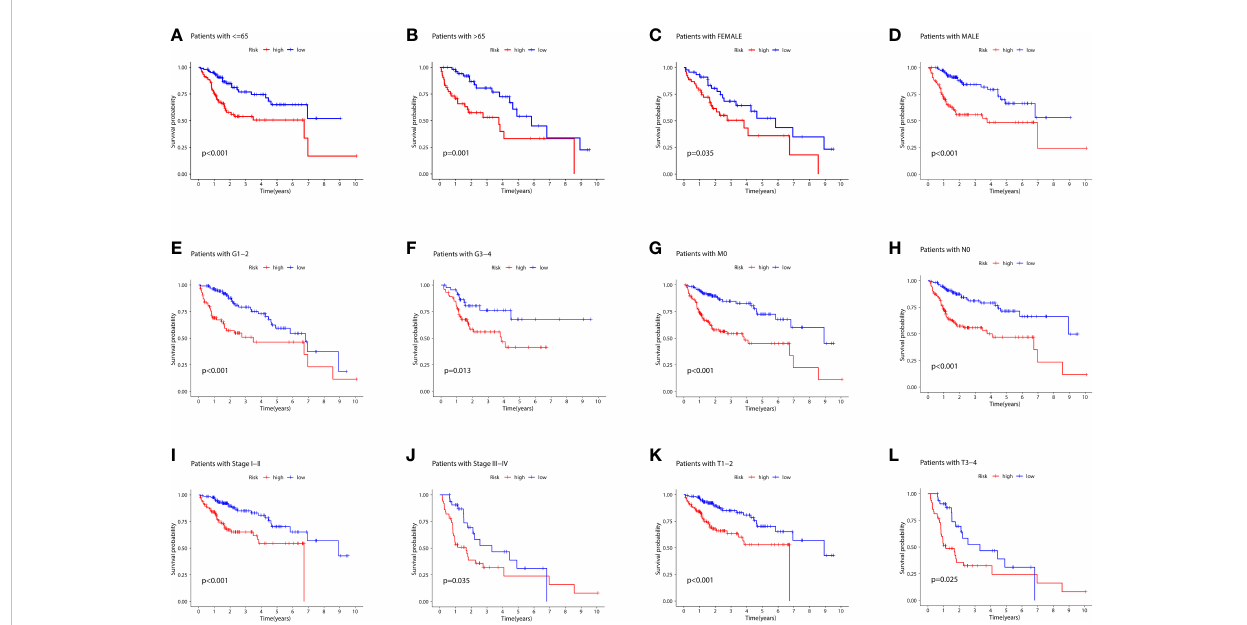
FIGURE 7 (A) K-M curves for age ≤ 65 for the different risk groups of LIHC patients. (B) K-M curves for age > 65 years for the different risk groups of LIHC patients. (C) K-M curves for female for the different risk groups of LIHC patients. (D) K-M curves for male for the different risk groups of LIHC patients. (E) K-M curves for stages G1-2 for the different risk groups of LIHC patients. (F) K-M curves for stages G3-4 for the different risk groups of LIHC patients. (G) K-M curves for stage M0 for the different risk groups of LIHC patients. (H) K-M curves for stage N0 for the different risk groups of LIHC patients. (I) K-M curves for stages I-II for the different risk groups of LIHC patients. (J) K-M curves for stages III-IV for the different risk groups of LIHC patients. (K) K-M curves for stages T1-2 for the different risk groups of LIHC patients. (L) K-M curves for stages T3-4 for the different risk groups of LIHC patients.